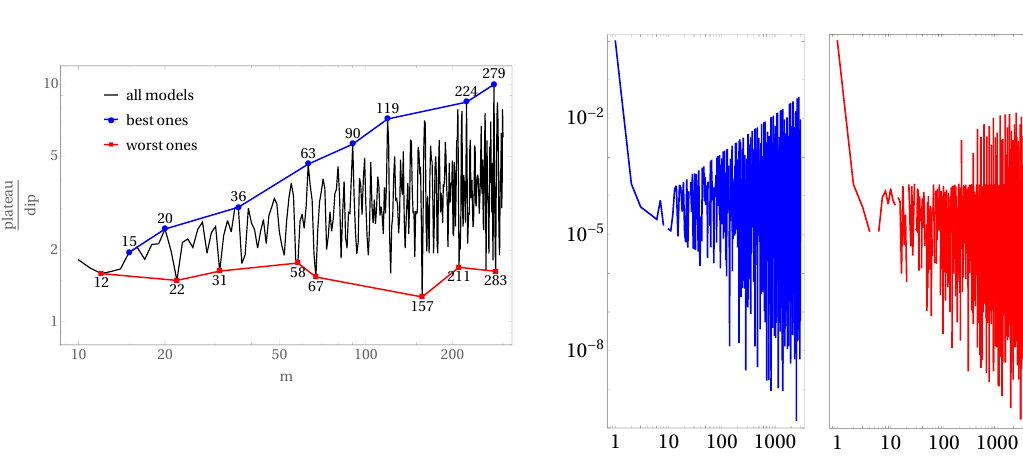
Figure 10 . Left: the behavior of the SFF’s plateau height over dip height ratio as a function of m . The plateau is computed using (4.10) and the dip is the mean of SFF between n = 1 and 10 without any average over m . The best and worst models are labeled by blue circles and red squares. The ratio grows with m for the best models while the worst models seem not to grow with m . Right: comparing two example SFFs with the large and small plateau-to-dip ratio. Their m indices are close but their behaviors are drastically di(cid:11)erent at late time. The best model ( m = 279) occasionally gets increasingly constructive interference that helps the SFF to grow, while the worst model ( m = 283) does not have constructive